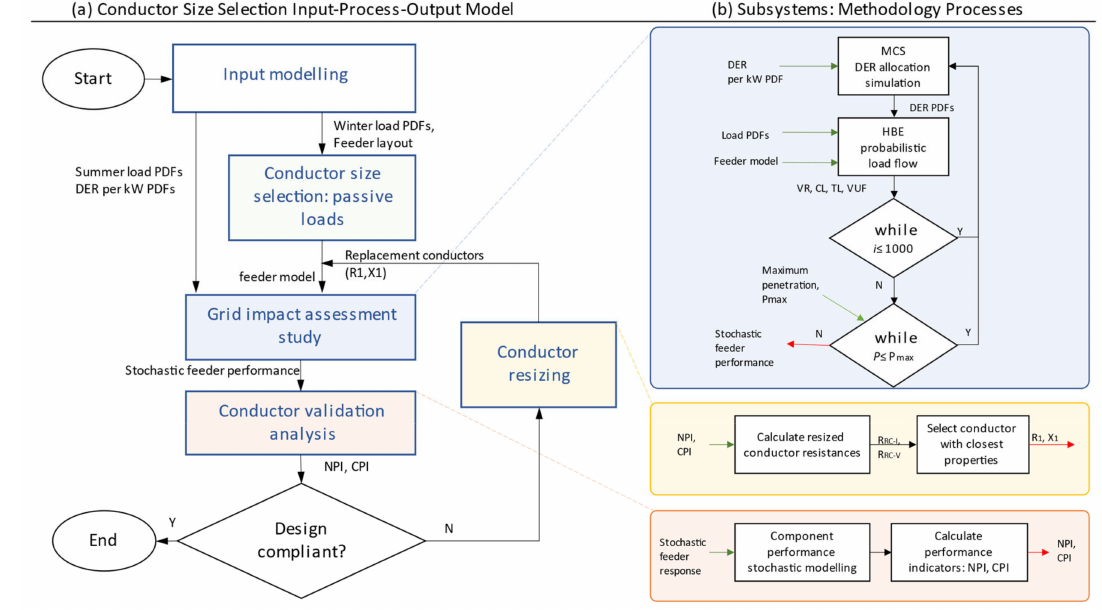
Figure 1. Methodology for the assessment of feeder performance and conductor size selection.